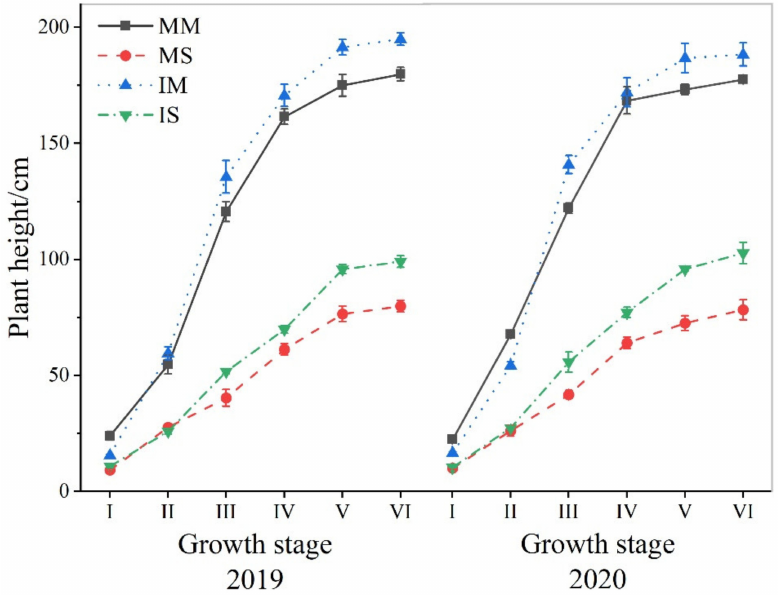
Figure 3. Dynamic changes of plant height of maize and soybean in monoculture and intercropping during 2019 and 2020. Abbreviations: MM—monocropping maize, MS—monocropping soybean, IM—intercropping maize, IS—intercropping soybean. In maize, I–VI mean seedling stage,